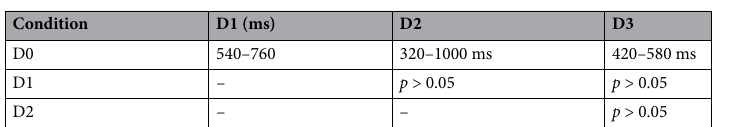
Table 2. Time intervals where a statistically significant difference was found between the time-course of alpha power of the different delay conditions [ p < 0.05, randomization-based ANOVA test, FDR corrected].